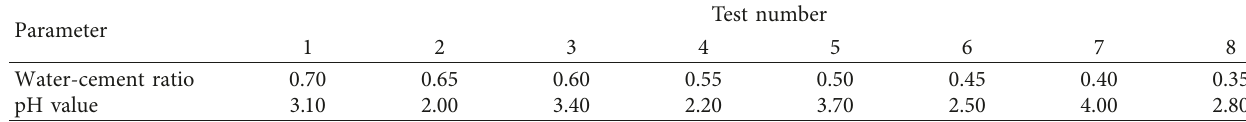
Table 2: Uniform test